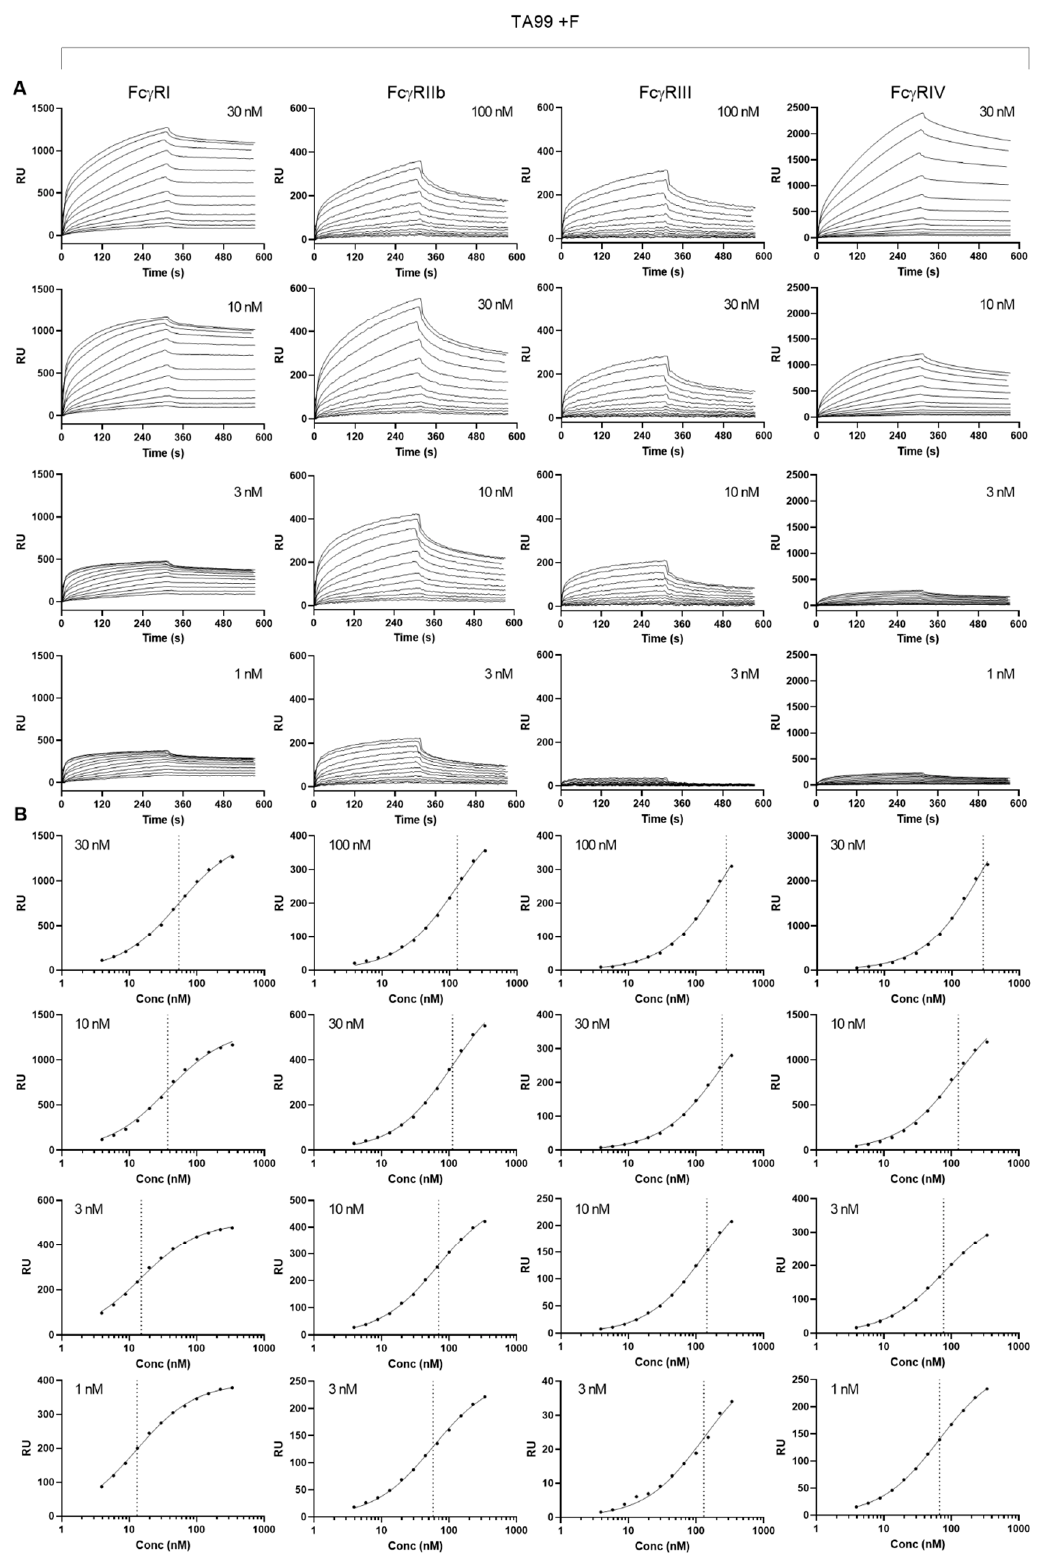
Figure 4. Affinity plots for fucosylated human IgG1 to mouse Fc γ R. Binding affinity was determined by Surface plasmon resonance using C-terminally site-specifically biotinylated Fc γ R coupled to streptavidin sensor arrays. hIgG1-TA99 flowed over the chip at concentrations ranging from 3.9 nM until to 337.5 nM at 1.5 dilutions for the different mouse Fc γ R at different densities as indicated. ( A ) Sensorgrams and ( B ) derived affinity plots. The affinities found at different receptor densities in ( B ) are indicated by vertical dotted lines, and used to calculated and interpolated of KD for Rmax of 500 (Figure 5).